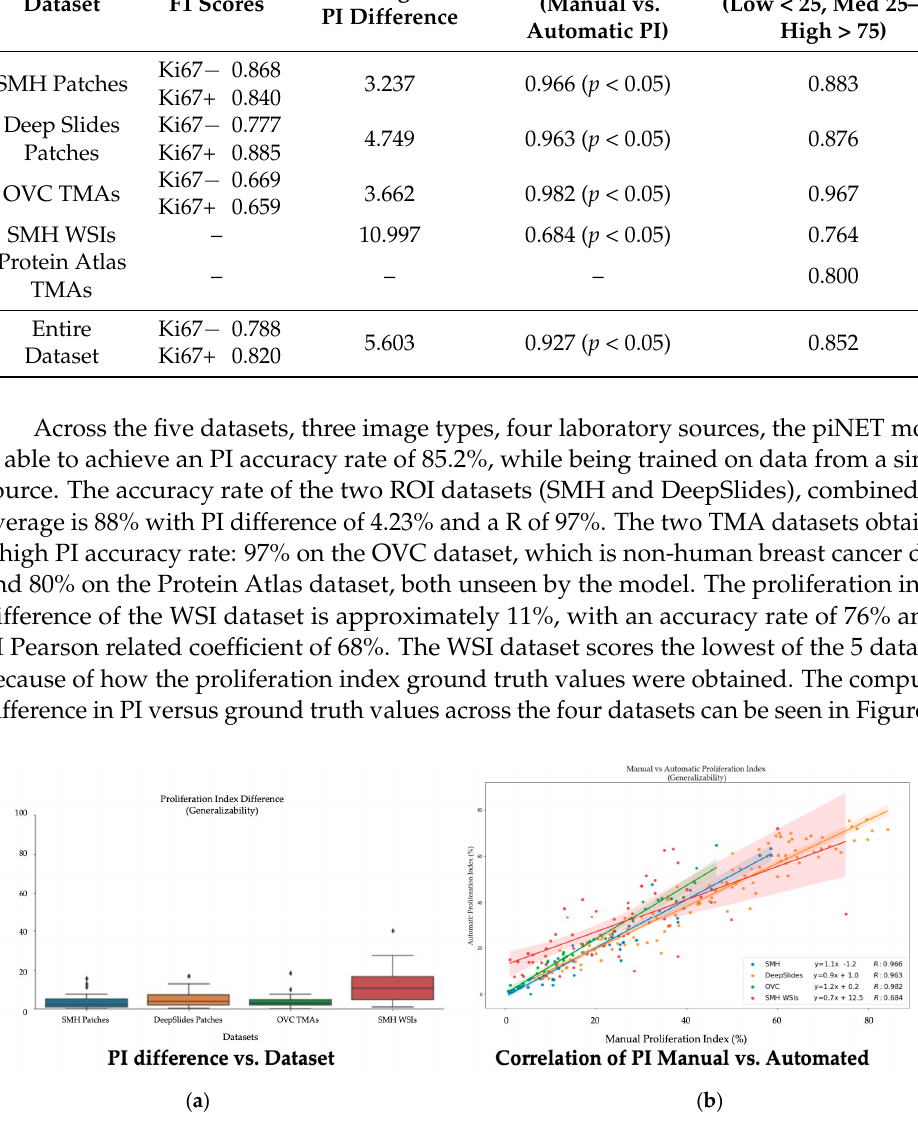
Figure 17. ( a ) PI difference and ( b ) manual vs. automated PI over all four